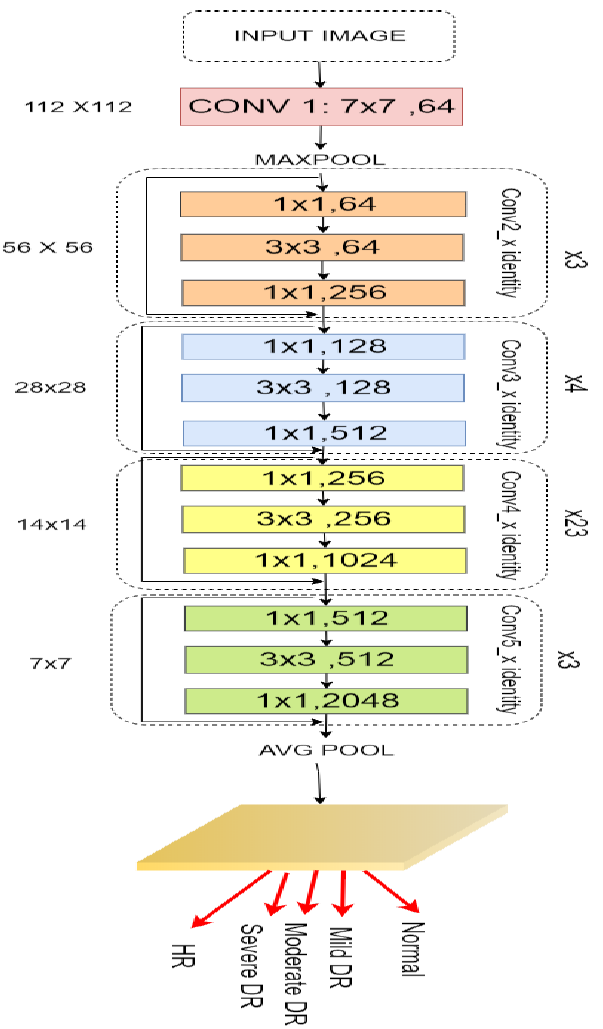
Figure 5. The proposed ResNet-101 architecture. The proposed network architecture is shown alongside the architecture of